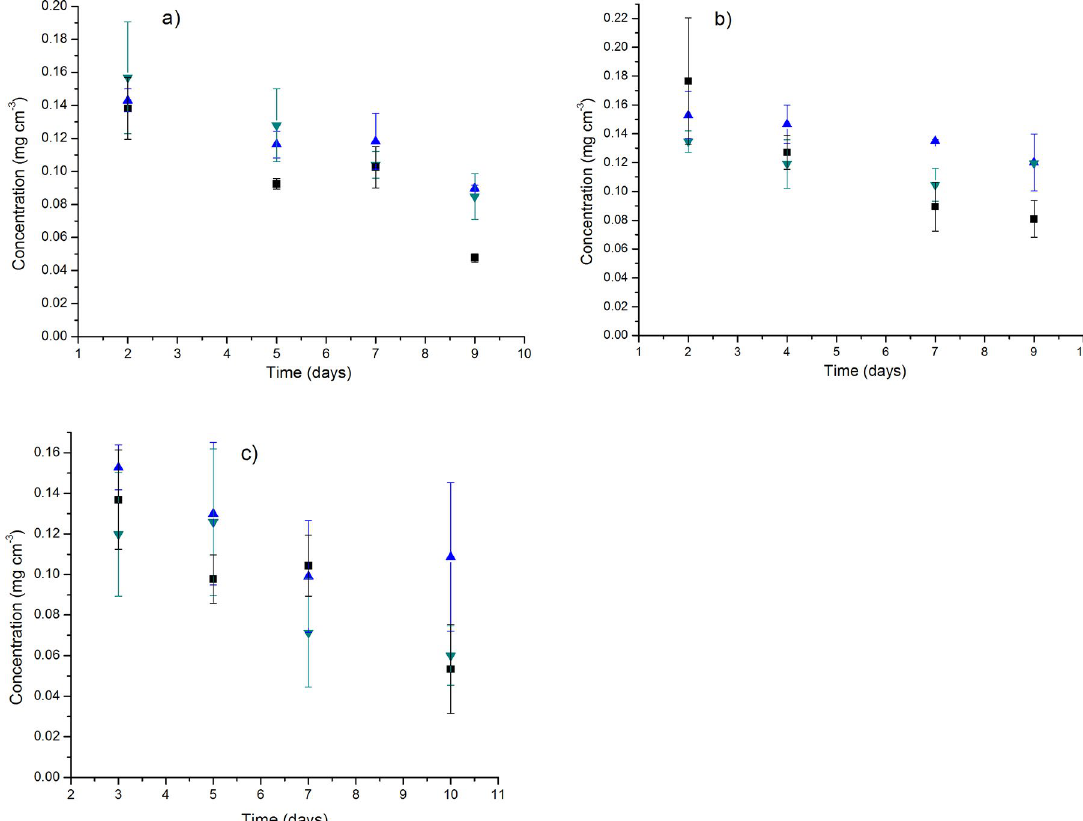
Figure 2. Variation of vitamin C concentration for NC light at 25 ºC; b) temperature of 35 ºC in absence of light and c) O